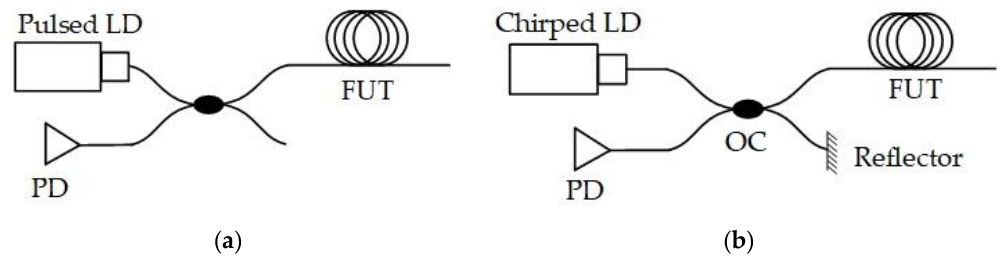
Figure 1. DAS implementations. ( a ) Classical system scheme of Φ -OTDR; ( b ) Classical system scheme of